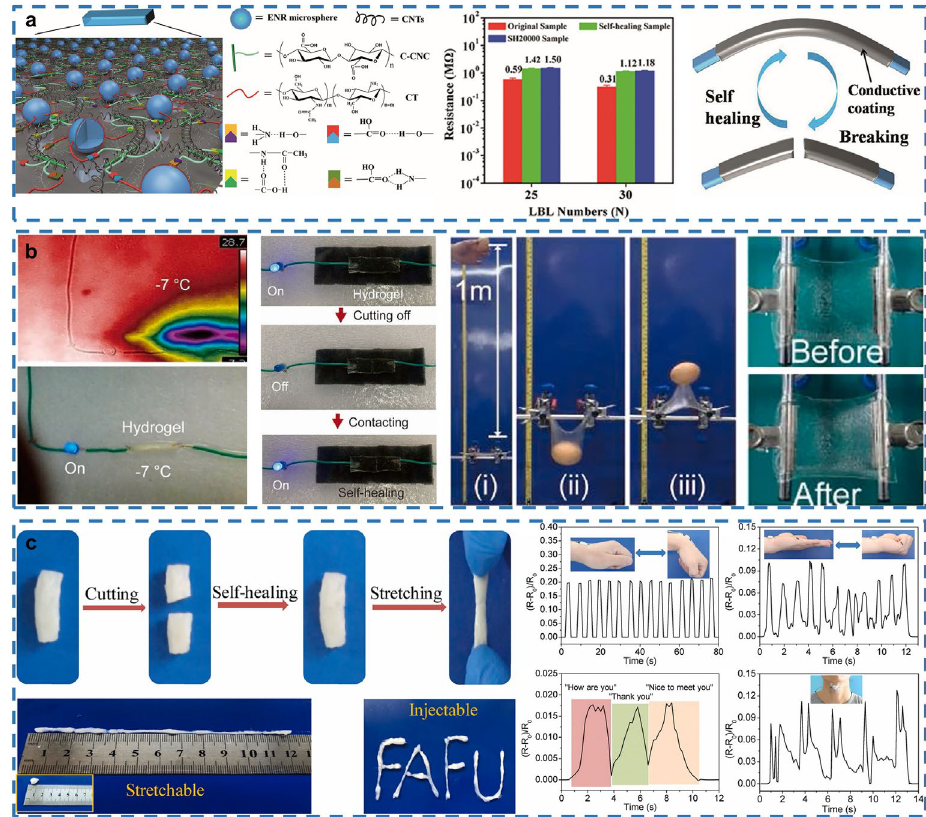
Figure 2. Self-healing human–machine interaction. ( a ) Multiple-hydrogen-bonding-elastomer-based self-healing sensor. Reprinted with permission from [55]. Copyright 2017, WILEY-VCH. ( b ) Conductive cold-resistant and elastic hydrogel-based bionic skin. Reprinted with permission from [104]. Copyright 2021, Elsevier. ( c ) Conductive poly(N-vinylpyrrolidone)/gallic acid hydrogel-based wearable sensor. Reproduced with permission from [106]. Copyright 2020, Elsevier.